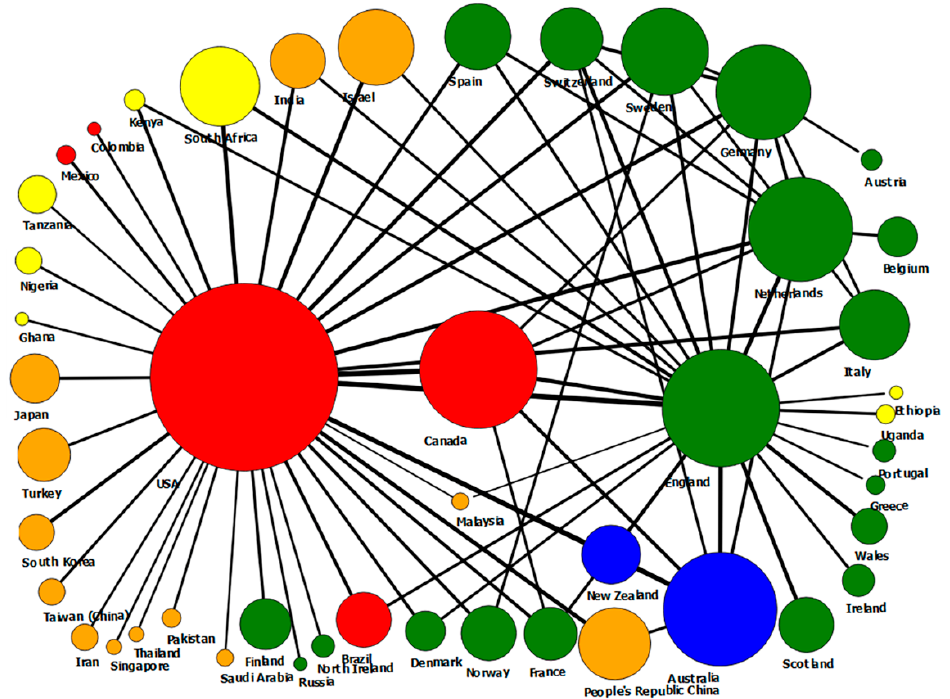
Figure 2. A global network of the most prolific countries (more than 50 papers). Note: America = Red; Europe = Green; Blue = Australia; Asia = Yellow, Africa & Middle East = Yellow.